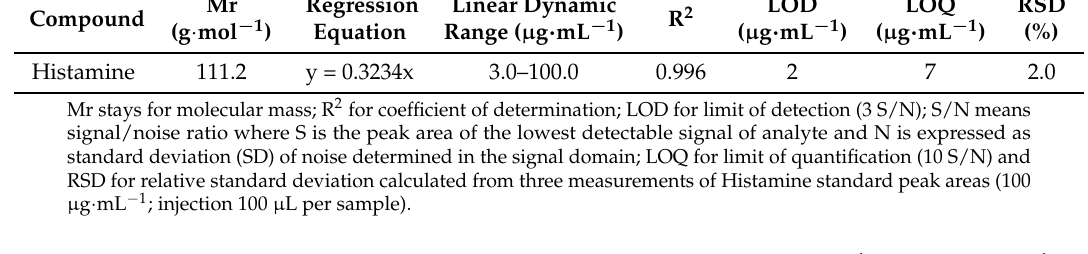
Table 3. Histamine extraction recoveries for PMPs of concentration 2 mg·mL − 1 and 12 mg·mL − 1 (MAN18 modified with Titanium (IV) isopropoxide).